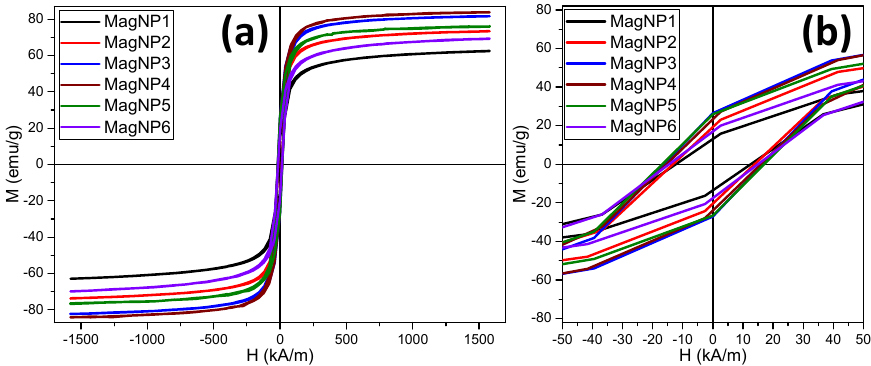
Figure 3. ( a ) Magnetization curves and ( b ) their low-field regime for all types of MagNPs recorded at 300 K. Table 2. Magnetic hysteresis parameters at room temperature for all six types of MagNPs.